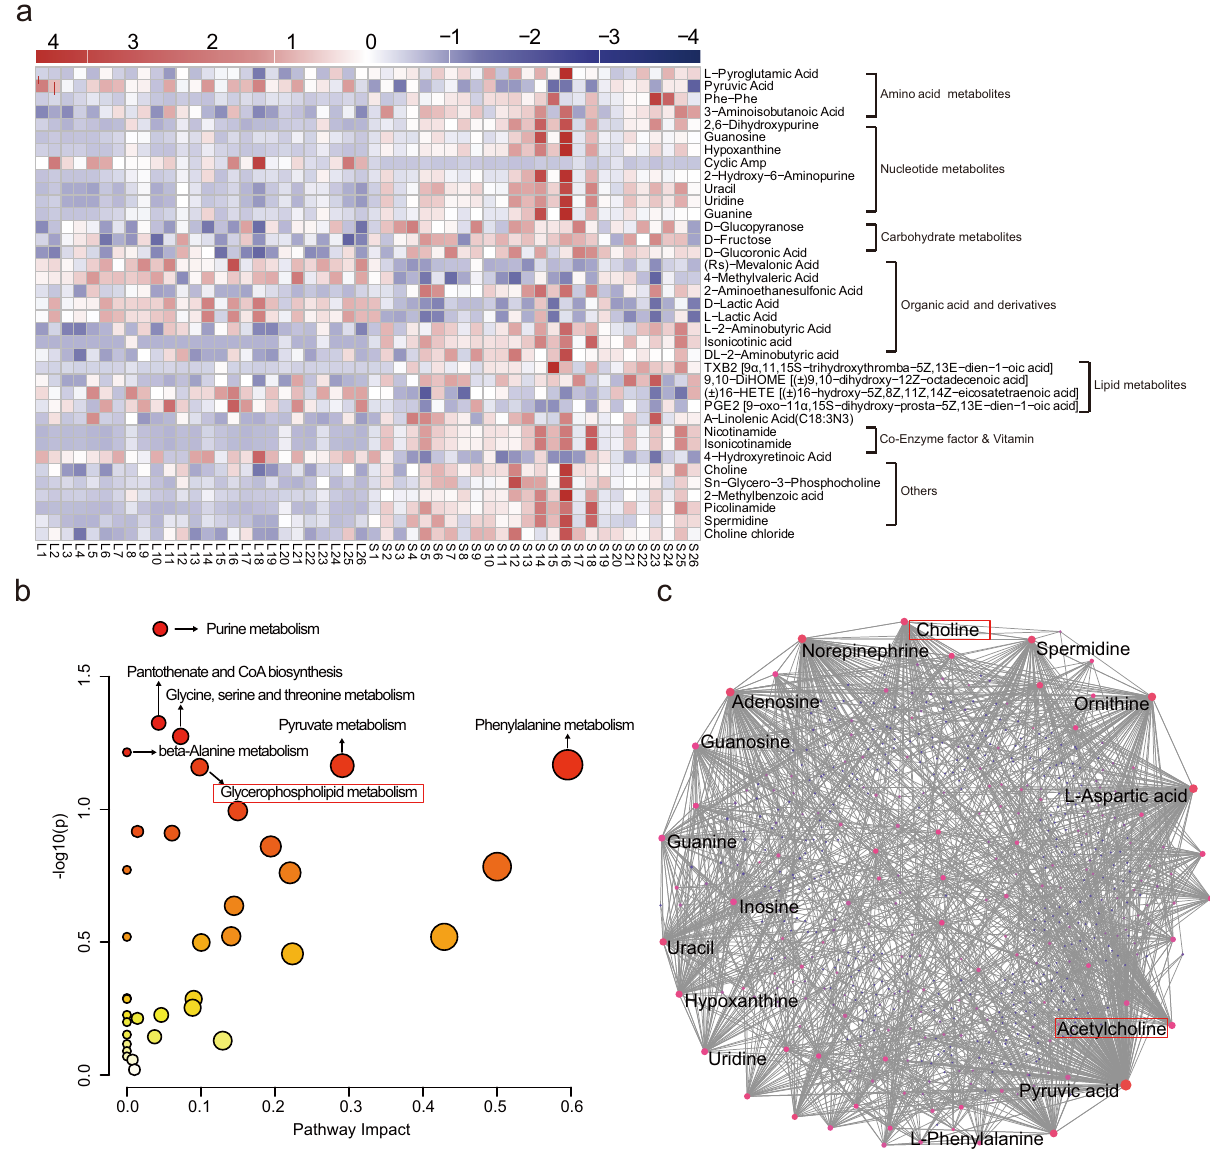
Fig. 3 Metabolomic pathway analysis of differential metabolites in follicular fl uid. a Heatmap illustrating the representative differential expression of 37 metabolites with VIP ≥ 2 and p < 0.03. b The pathway analysis results of the 116 differential metabolites. c Network analysis results of the 116 differential